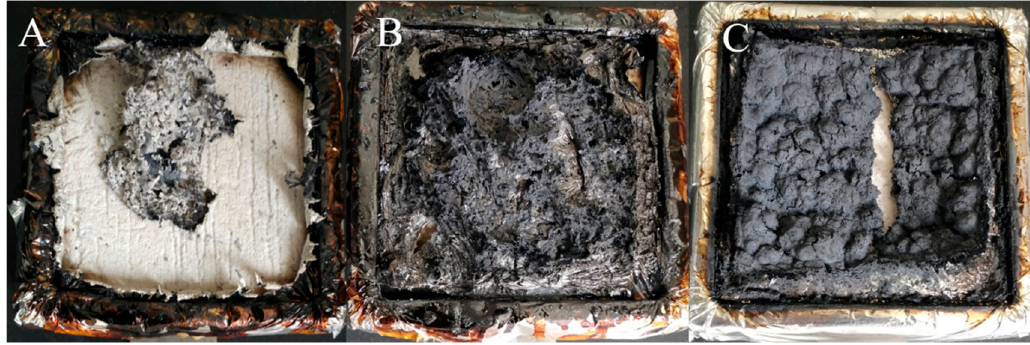
Figure 4. Digital images of char residue obtained from cone calorimeter test: ( A ) TAD0; ( B ) TAD12; and ( C ) TAD6EG6.